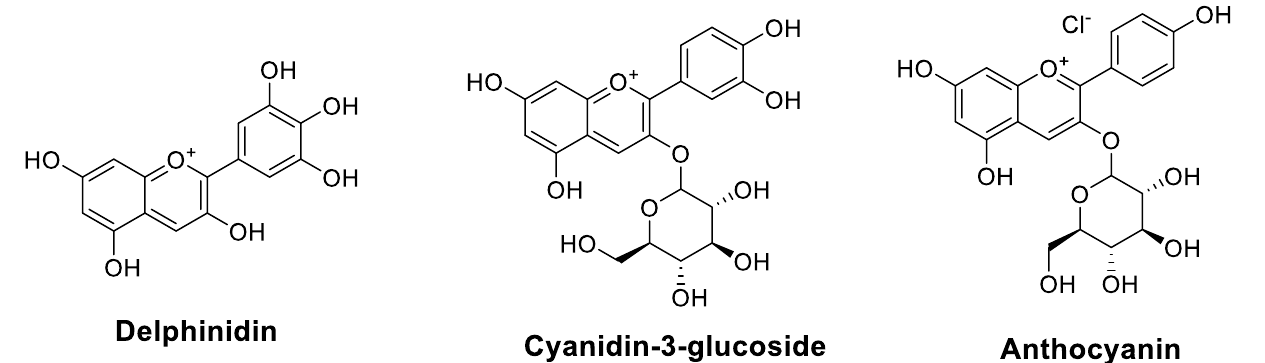
Figure 4. Chemical structures of anthocyanidins that improve chemosensitivity of anticancer drugs. Table 2. Anthocyanidins that could enhance the chemosensitivity of cancer drugs.